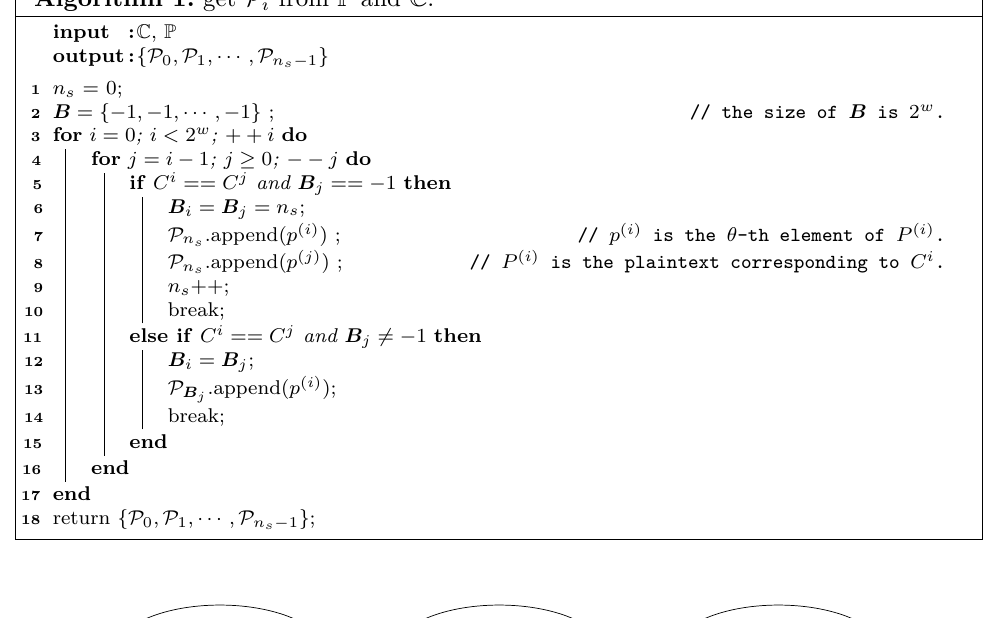
Algorithm 1 traverses all ciphertexts and puts the θ -th element of plaintexts with the same ciphertexts into the set P . i Algorithm 1: get P i from P and C .